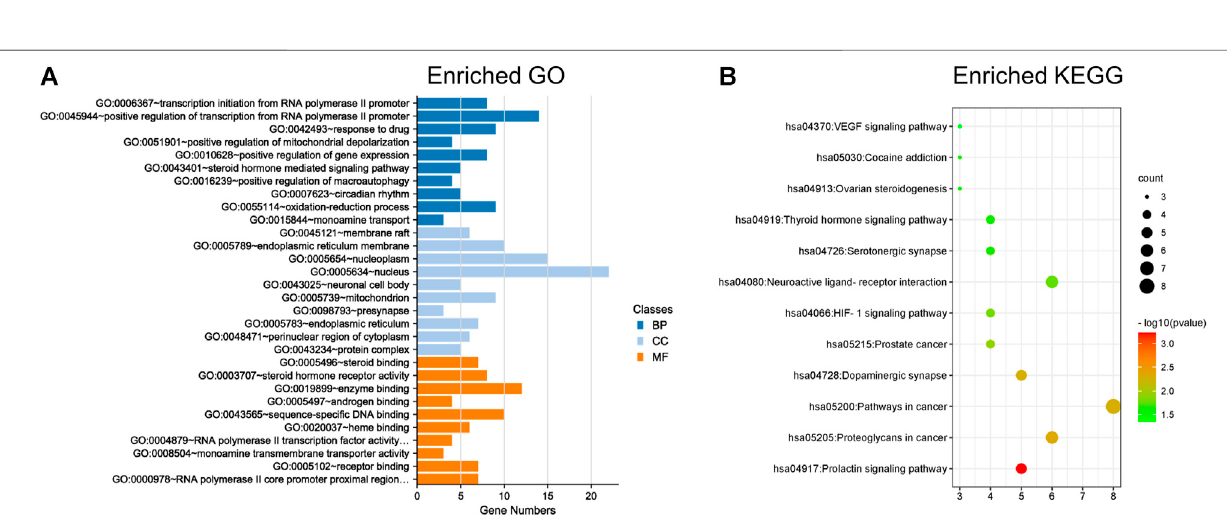
Frontiers in Pharmacology |